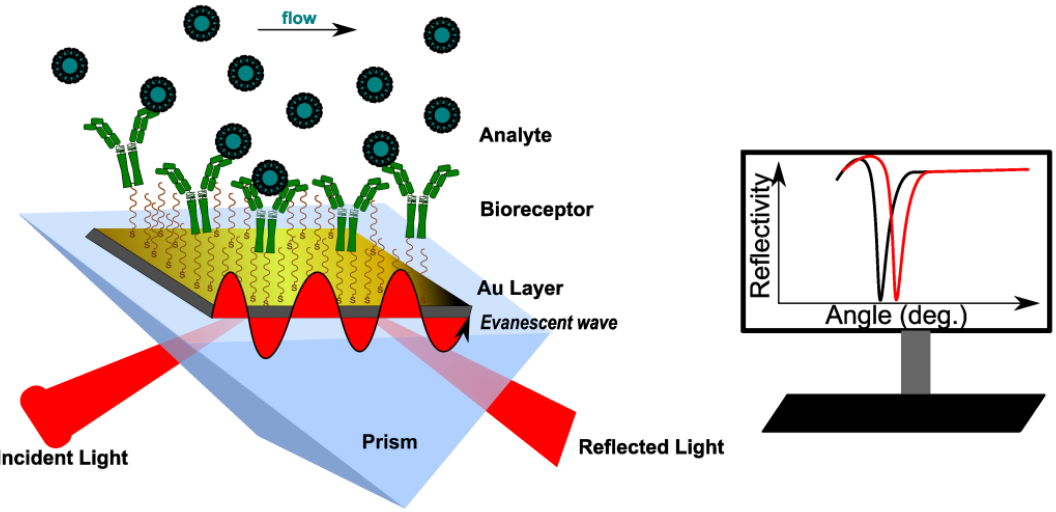
Figure 1. Principle of conventional SPR biosensor with Kretschmann configuration. The analyte binding to the immobilized bioreceptor causes a change in RI near the surface, recorded as the shift of the resonance angle (here, measured at a fixed wavelength). RI reaches a constant value at equi- librium.